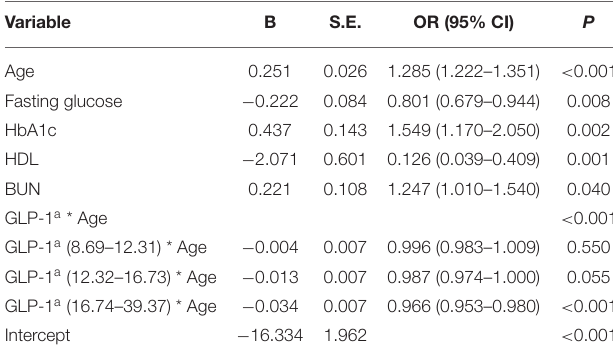
TABLE 4 | Multivariable regression analysis for the risk of GLP-1 interacting with Age in CAVD.